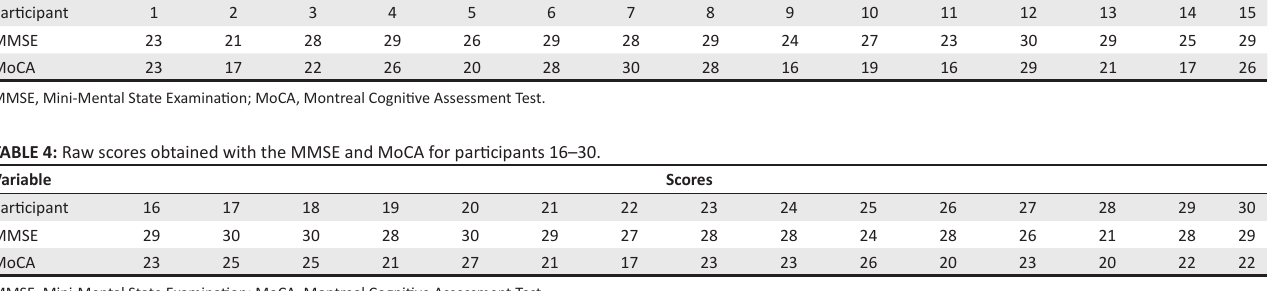
TABLE 3: Raw scores obtained with the MMSE and MoCA for participants 1–15. Variable Scores